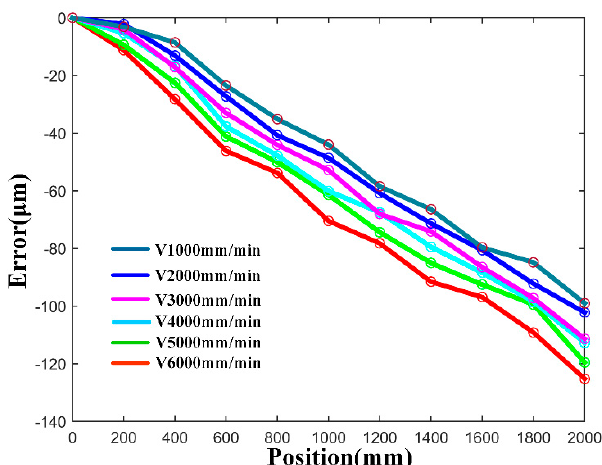
Figure 17. Uncompensated error results of the tool center.